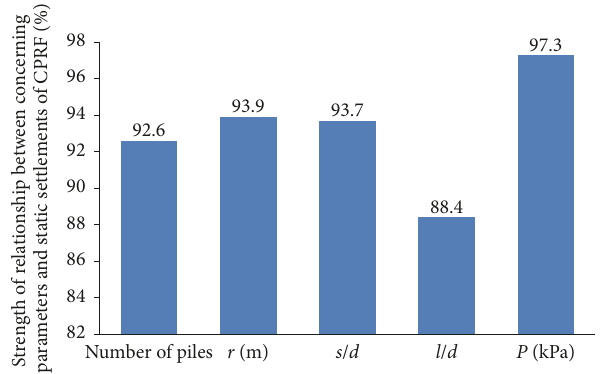
Figure 24: Strength of relationship between input parameters and CPRF settlements in the static case.